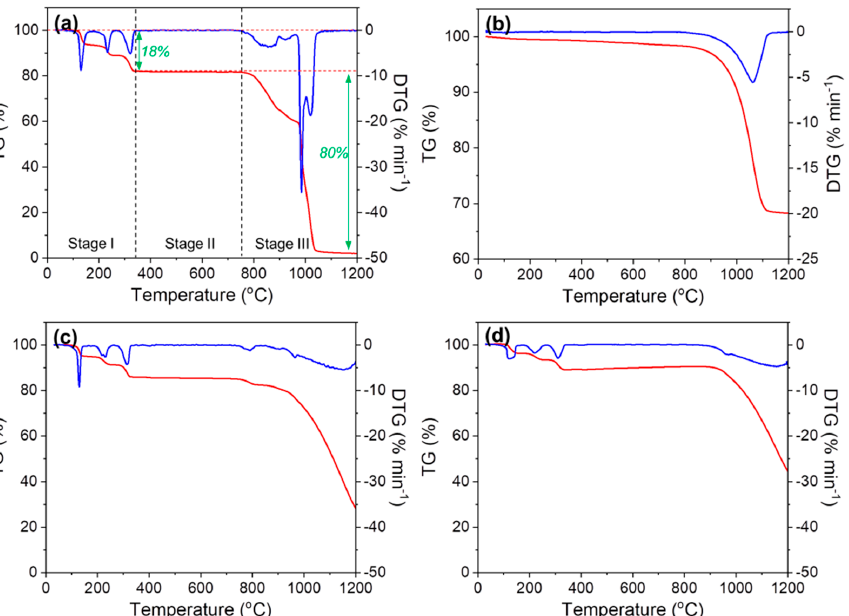
Figure 2. TG − DTG curves of the precursors for SFMO at 20 − 1200 °C. ( a ) As − received (NH 4 ) 6 Mo 7 O 24 ·4H 2 O; ( b ) As-received SrCO 3 ; ( c ) Fe 2 O 3 -MoO 3 mixture with Fe:Mo = 2:3; ( d ) Fe 2 O 3